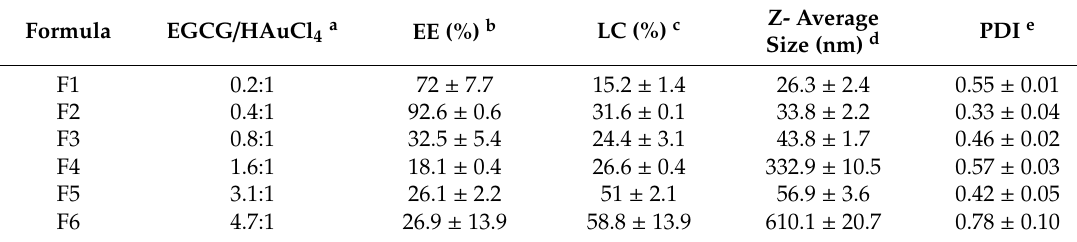
Figure 1. TEM photomicrograph of EGCG-loaded GNPs (formulation F2) showing spherical, discrete particles with an average size of 13.6 ± 5.1 nm. Table 1. Composition and properties of various EGCG-loaded GNPs.